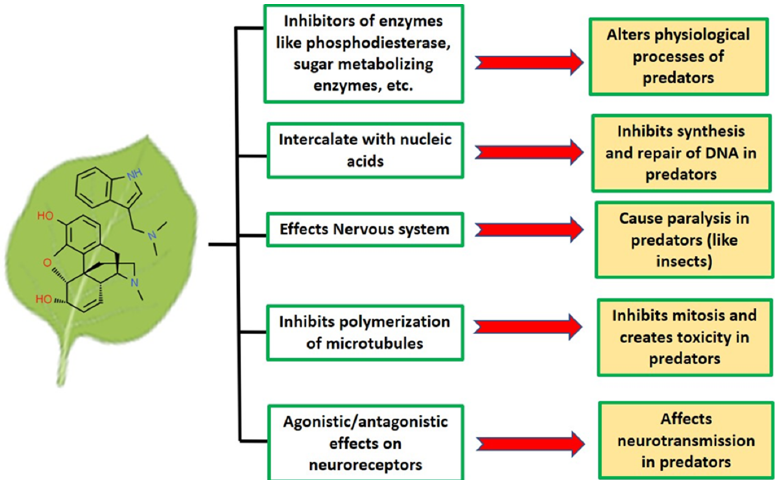
Figure 5. The mechanism of action of alkaloids. Alkaloids act as a chemical barrier that protects plants from predators, such as herbivorous insects and vertebrates; pathogenic bacteria and fungi; and parasitic plants. Various mechanisms employed by plants using alkaloids create harmful effects in predators and are depicted in the